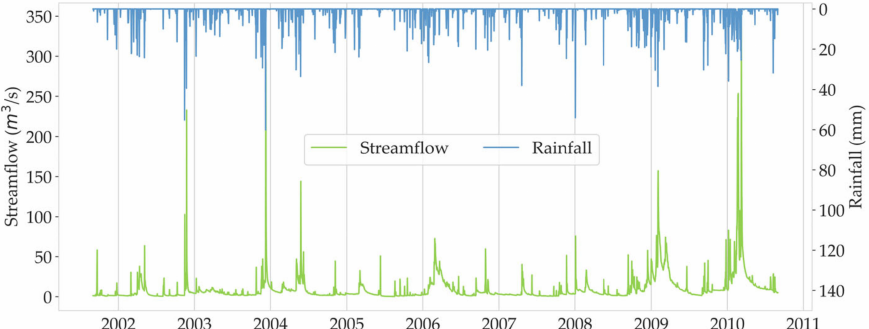
Figure 2. Ait Ouchen streamflow and rainfall data used in this study (1 September 2001–31 August 2010).